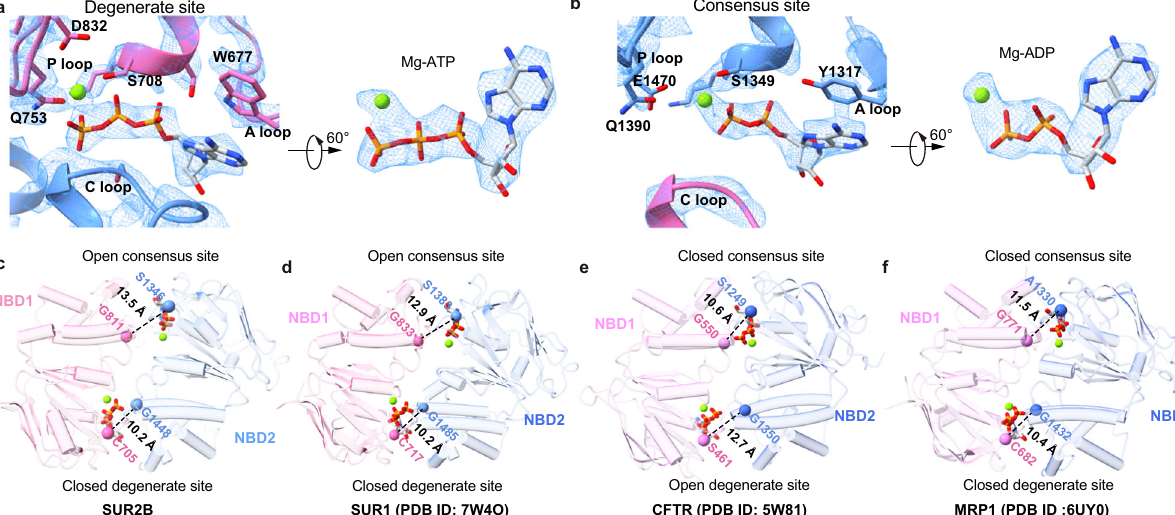
Fig. 4 Structural comparisons of the NBDs of ABCC family members. a , b Close-up views of EM densities at the degenerate site and the consensus sites. c Bottom view of the NBD1 and NBD2 of SUR2B in the Mg-nucleotides and P1075-bound state. ATP and ADP molecules are shown as sticks. Mg 2 + are shown as green spheres. The color scheme is the same as that in Fig. 1. The C α distances between glycine in the Walker A motif and serine (cysteine at the degenerate site) in the ABC signature motif are shown as dashed lines. d NBD structures of SUR1. View of SUR1 (PDB ID: 7W4O) NBDs from the bottom. ATP and ADP molecules are shown as sticks. C α distances between glycine in the Walker A motif and serine (cysteine at the degenerate site and alanine at the consensus site) in the ABC signature motif are shown as dashed lines. e NBD structures of CFTR. View of CFTR (PDB ID: 5W81) NBDs from the bottom. ATP and ADP molecules are shown as sticks. C α distances between glycine in the Walker A motif and serine in the ABC signature motif are shown as dashed lines. f NBD structures of MRP1. View of MRP1 (PDB ID: 6UY0) NBDs from the bottom. ATP and ADP molecules are shown as sticks. C α distances between glycine in the Walker A motif and serine (cysteine at the degenerate site and alanine at the consensus site) in the ABC signature motif are shown as dashed